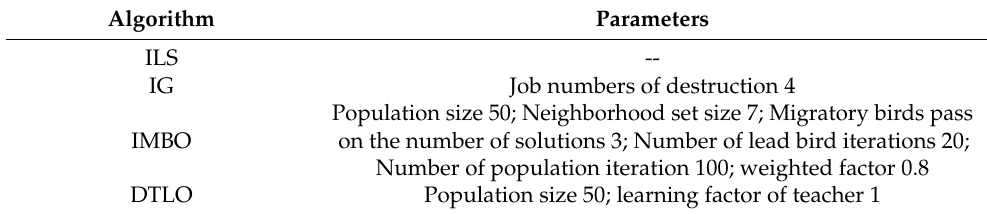
Table 3. Parameter determination of the compared